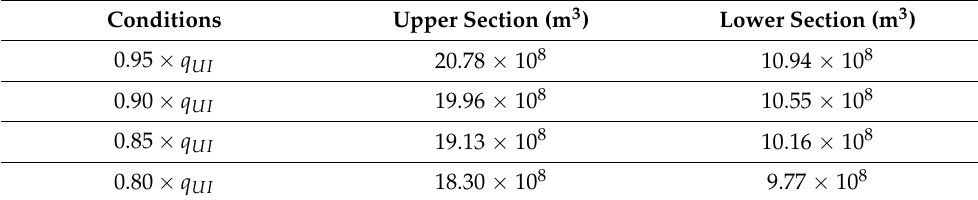
Table 8. The water consumption in 2045 after changing water quota for